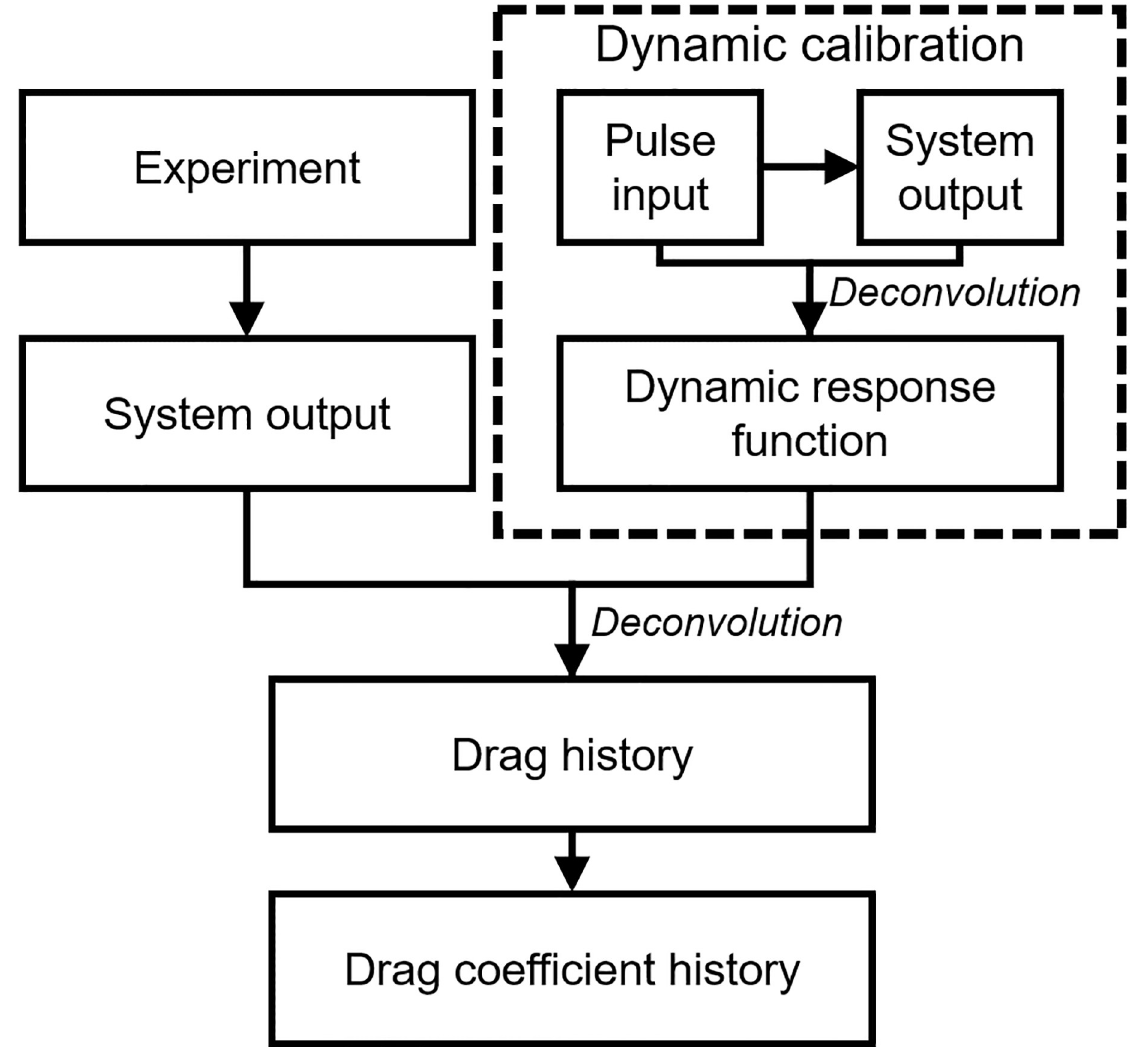
Fig 9. Drag coefficient acquisition using the MST and the